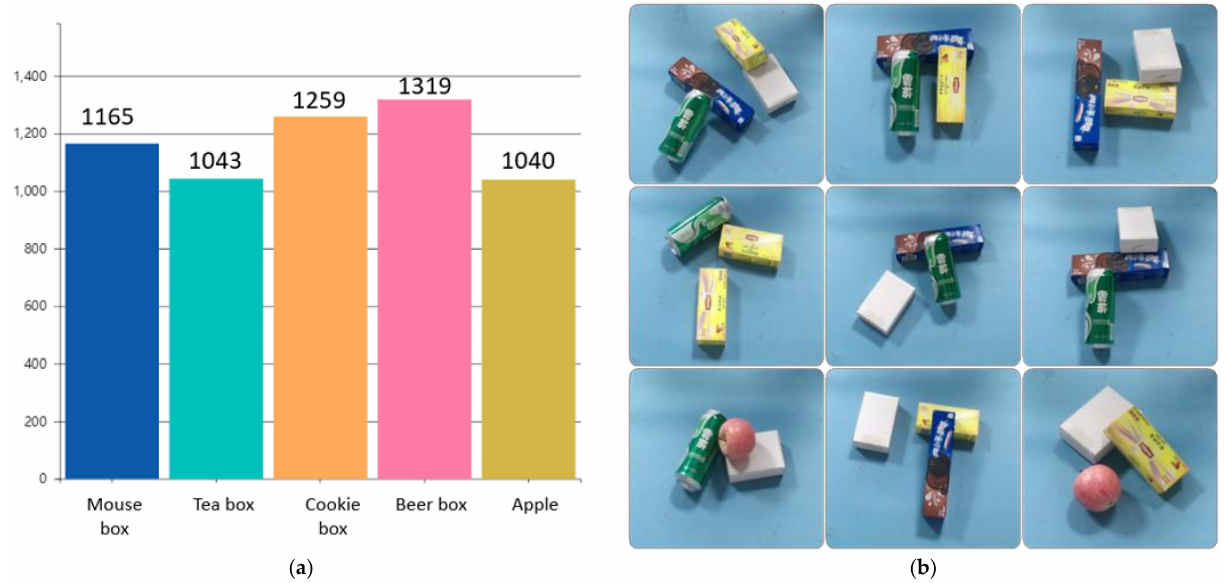
Figure 4. Data set object number distribution ( a ) and data set image examples ( b ).